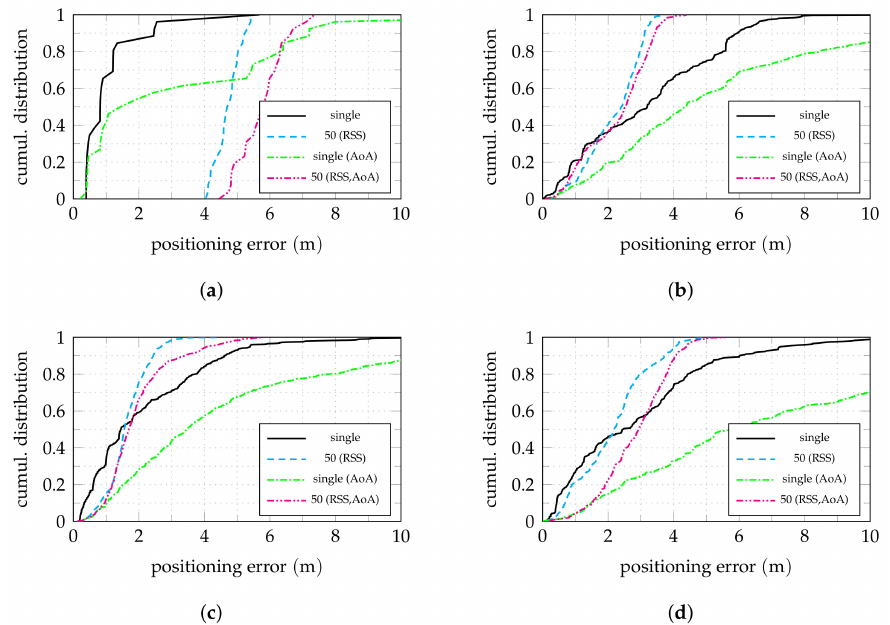
Figure 12. Cumulative absolute error distributions for effects of different clustering approaches in the four aisles. A number of N cl = 50 nodes is used for clustering. All anchors active. The TDoA+AoA (not explicitly indicated) and the AoA-only cases are compared. The curves for single nodes are the same as in Figure 7a. ( a ) Aisle 0. ( b ) Aisle 1. ( c ) Aisle 2. ( d ) Aisle